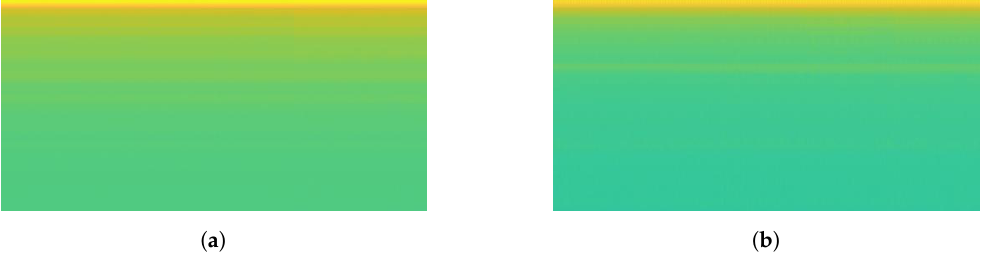
Figure 20. The spectrogram results of mixed load data containing Motorola Phone Charger: ( a ) Load Combination of LED Panel, Oil Heater Power-1, and Motorola Phone Charger; ( b ) Load Combination of Vaio Laptop, Hair Dryer Super-1, and Motorola Phone Charger.